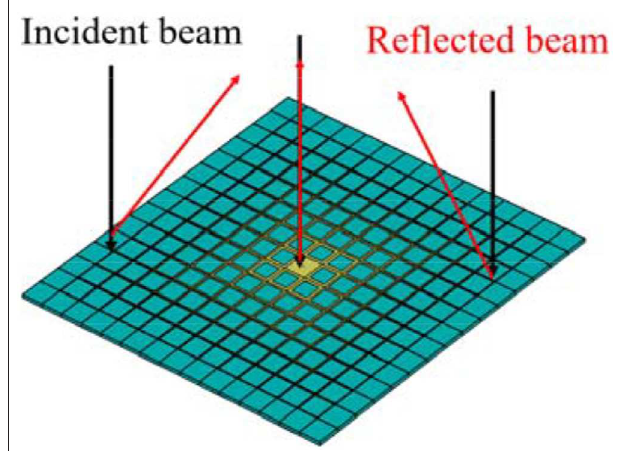
FIGURE 3 | Schematic diagram of a gradient high-impedance metasurface reflectarray with M × N elements consisting of square elements of different sizes.